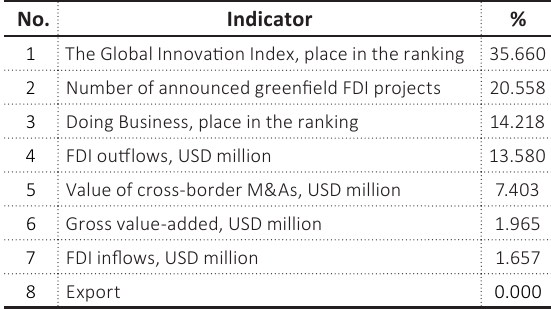
Table 5. Indicators’ weight in attributing a country to a particular